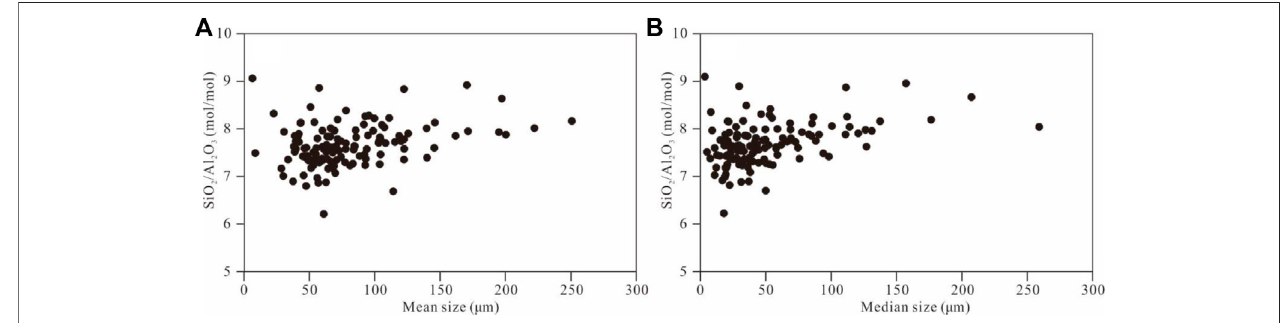
FIGURE 6 | Relationship between the SiO 2 /Al 2 O 3 ratio and the mean grain size (A) and median grain size (B) of